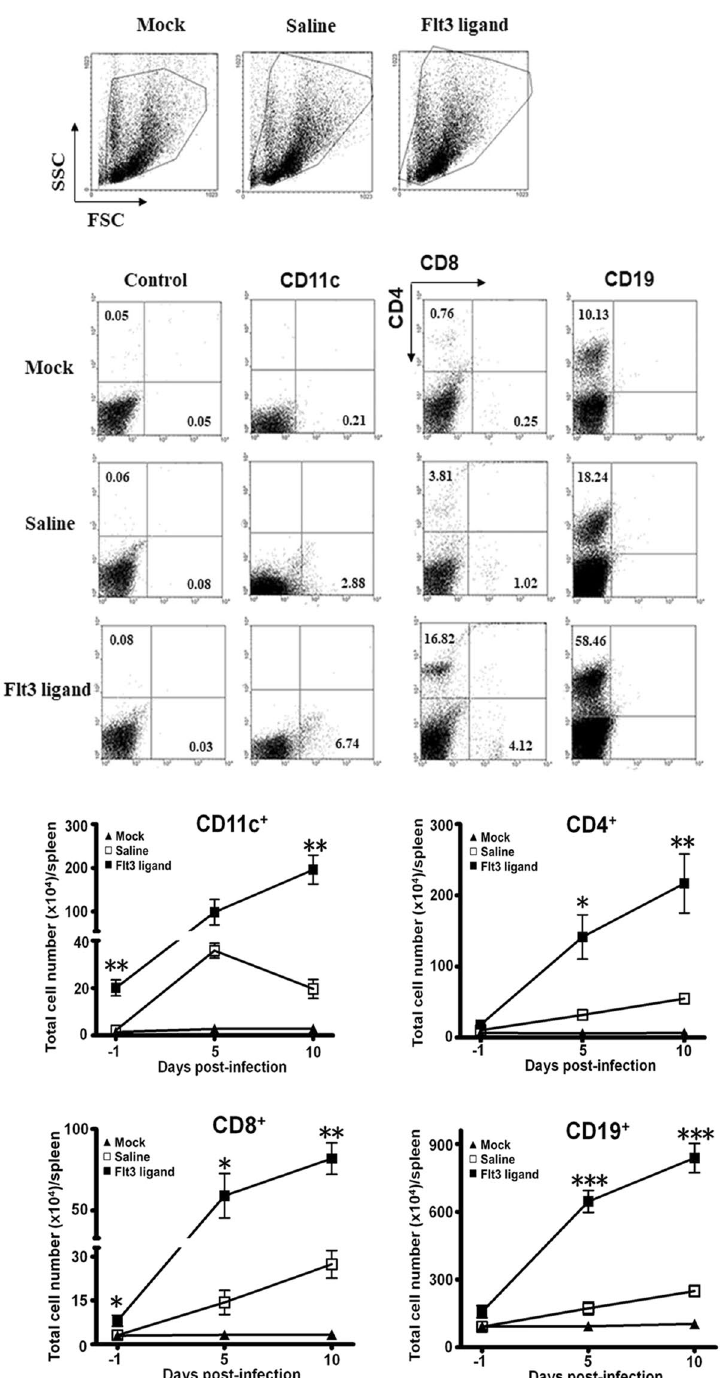
Figure 2. Flt3 ligand treatment increases the numbers of DCs and lymphocytes in the mouse spleen. Infected mice were pretreated with saline (Saline) or Flt3 ligand (Flt3 ligand). Mice without treatment and infection (Mock) served as a control. Splenocytes were analyzed by flow cytometry, the representative data are shown. The numbers of CD11c + DCs, CD4 + T cells, CD8 + T cells, and CD19 + B cells in mouse spleens at the indicated times are shown. Data represent means ± SEs of 4 samples per data point. * P < 0.05; ** P < 0.01; and *** P < 0.001 compared with the saline-treated groups at the same time